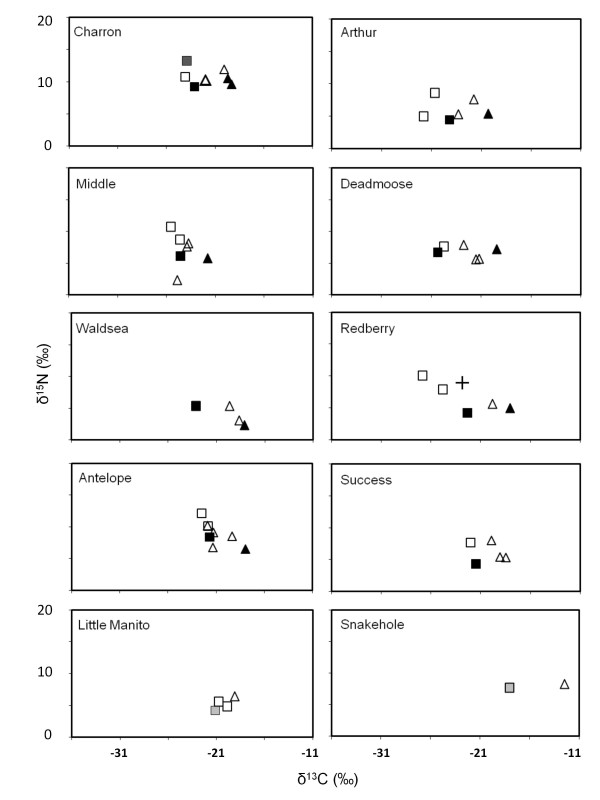
A and B: Stable isotope bi-plots for the 20 study lakes, with δ15N on the Y-axis and δ13C on the X-axis. Lakes are sorted by salinity (see Table 1), increasing within rows from row 1 to row 10. Data are averaged over the four sampling dates (June 2007, August 2007, June 2008, August 2008). Fish taxa are indicated by crosses (+), zooplankton by squares (□), and littoral invertebrate by triangles (Δ). Zooplankton is further separated into cladocerans (black squares, ■), copepods (open squares, □), invertebrate predators (i.e., Leptodora or Chaoborus; dark grey squares, ■) and other macroinvertebrates (e.g., corixids; light grey squares, ■). Within littoral invertebrates, amphipods are indicated by black triangles (▲).